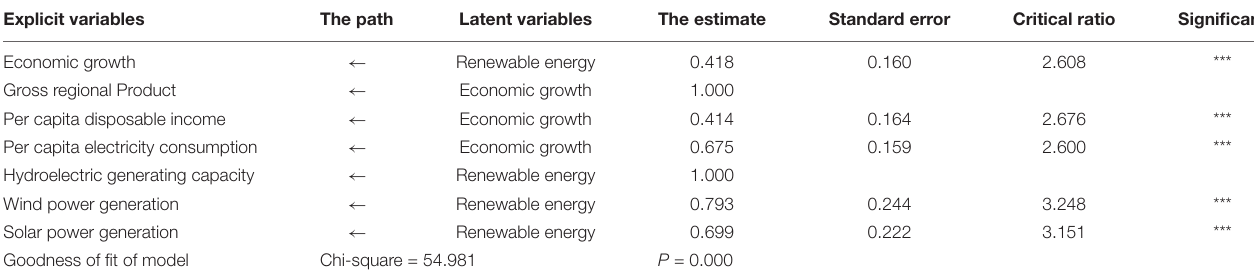
TABLE 5 | Parameter estimation of structural equation of the impact of renewable energy development on regional economic growth. Explicit variables The path Latent variables The estimate Standard error Critical ratio Significant